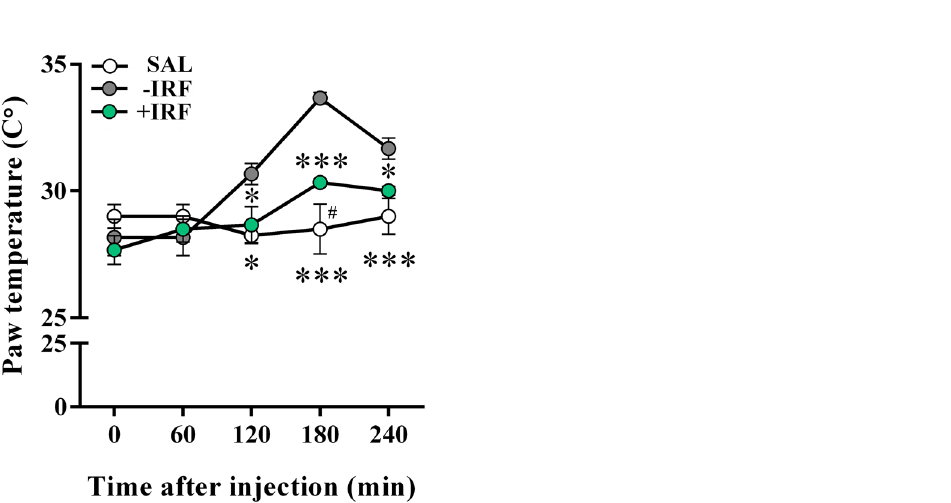
Figure 7. Influence of exposure to IR fibre bedding on the paw temperature of rats with carrageenan-inflamed paws. Rats housed in cages with IR fibre bedding (+IRF) or in cages with standard wooden shaving bedding (−IRF) were injected with carrageenan. Of note, rats were transferred to cages with IR fibre bedding five days before immunization. Rats housed in the cages with standard wooden shaving bedding were injected with saline to serve as an additional control (SAL rats). Line graph (created using GraphPad Prism version 7.00 for Windows, GraphPad Software, La Jolla California USA; https ://www.graph pad.com) indicates the surface paw temperature measured before and after carrageenan or saline injection in +IRF, –IRF and SAL rats. Results are expressed as mean ± SEM. n = 6 rats/group.* p ≤ 0.05 and *** p ≤ 0.001 vs –IRF; and # p ≤ 0.05 vs